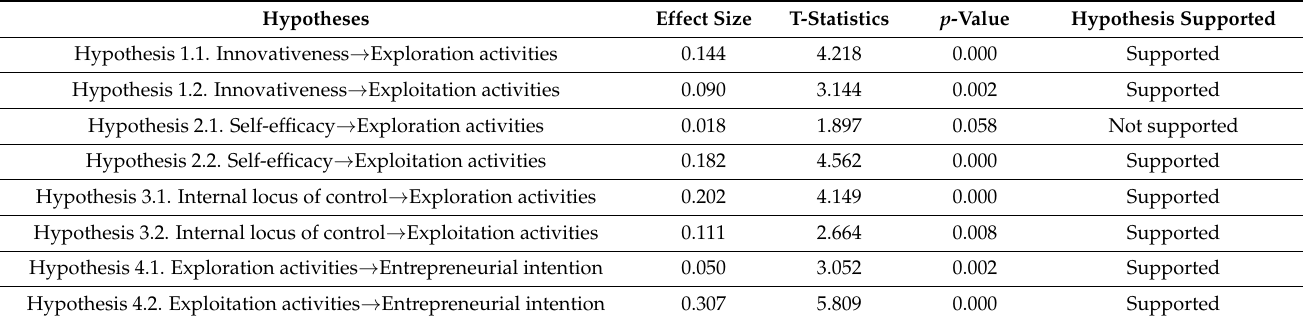
Table 7. Results of the hypothesis tests.